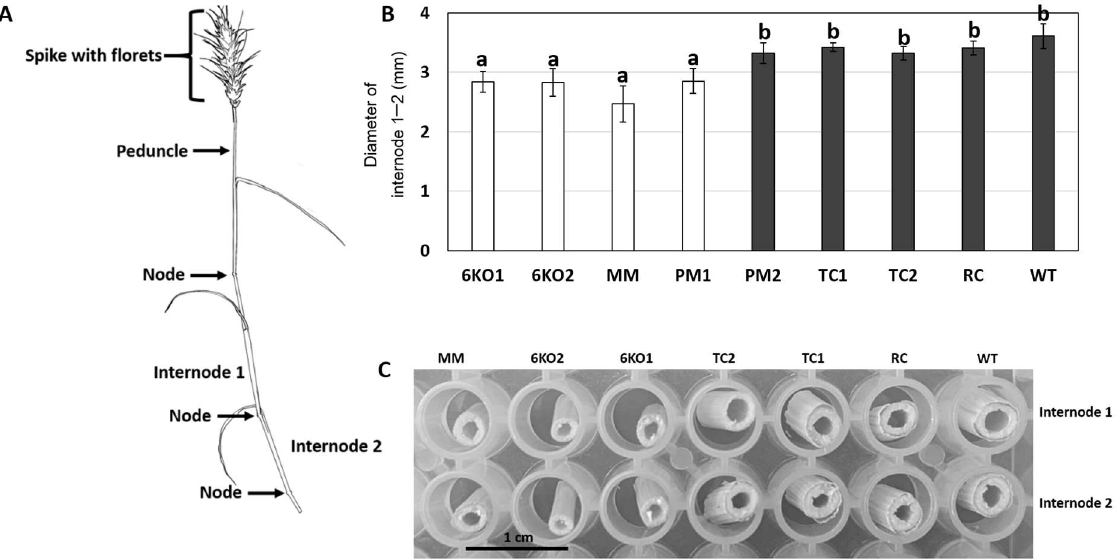
Figure 3. Stem phenotype in Sal1 mutant Bobwhite plants. ( A ) Wheat stem diagram with labelled parts. ( B ) Width (mm) of internodes 2 and 3 of the primary stem of well-watered plants (see Table 2 for descriptions of each line). Letters show statistically significant differences ( p < 0.01; n = 5). ( C ) Image of stem cross-sections of internodes 1 and 2.